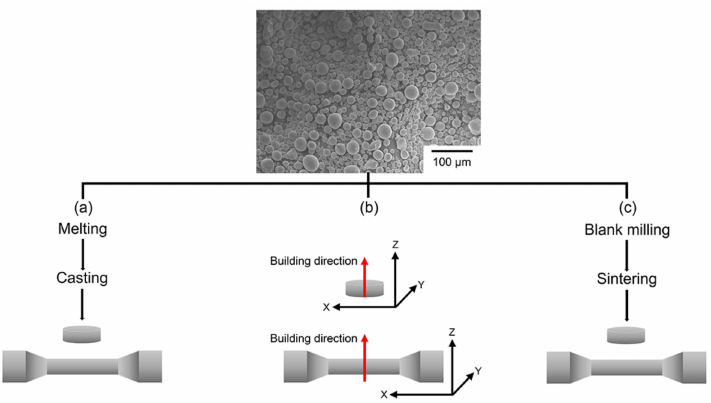
Figure 1. Schematic diagram of three manufacturing processes (lower) using single spherical Ni–Cr– Mo alloy (upper, SEM image, magnification = 250 × ) for specimen preparation: LWC ( a ), SLM ( b ), and SMM ( c